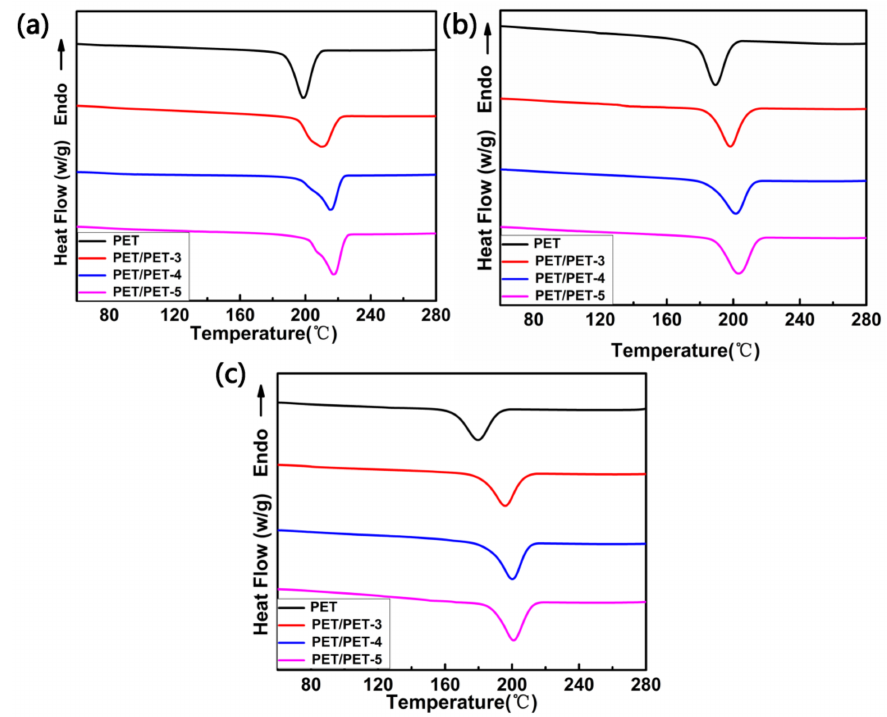
Figure 8. DSC curves for PET, PET/PET-3, PET/PET-4 and PET/PET-5 at different cooling rates.